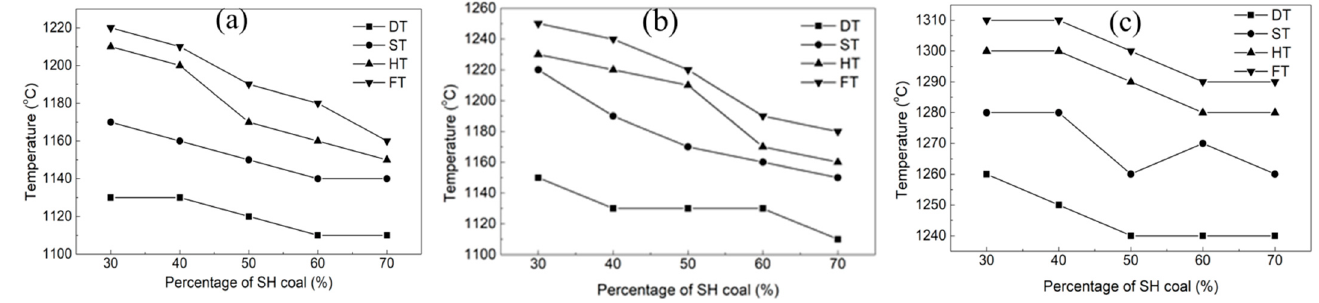
Figure 2. Ash fusion temperature of the coal blended with SH coal. ( a ) KG; ( b ) YK; ( c ) HS.